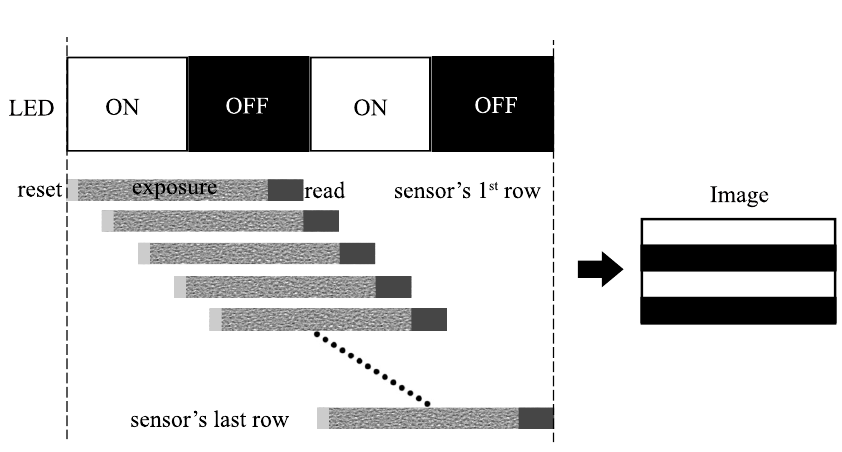
Figure 1. Image acquisition in a CMOS